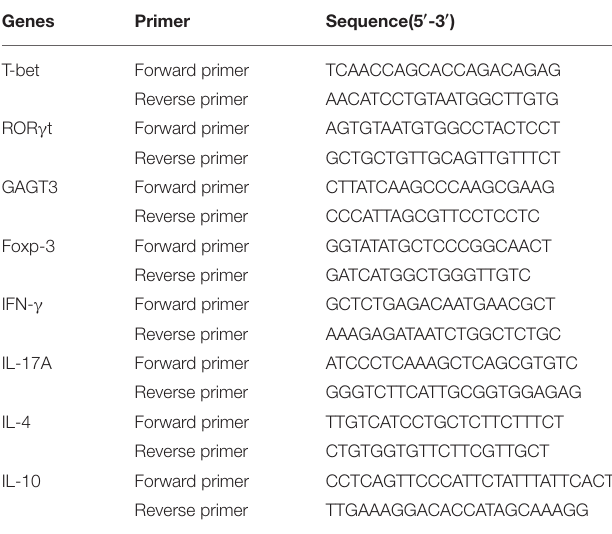
TABLE 4 | Primers used for real-time PCR